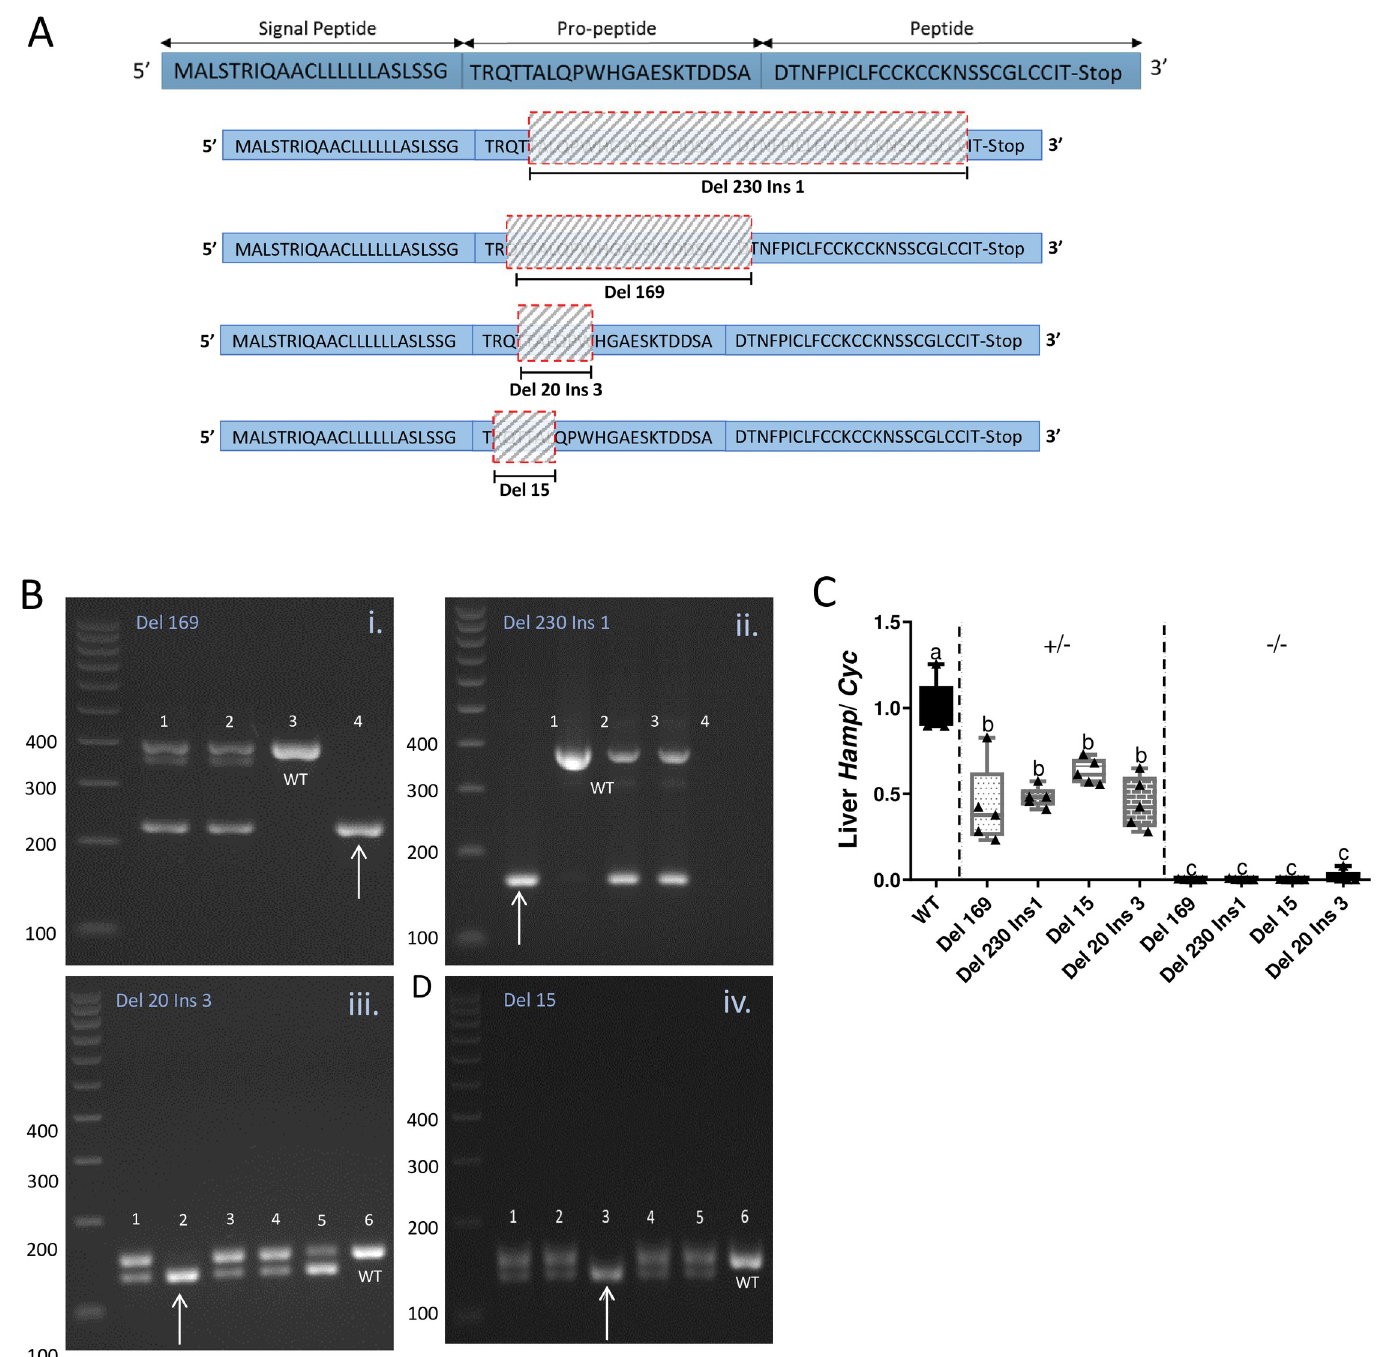
Fig 1. Hamp ablation strategy and confirmation. Four hepcidin KO rat lines were generated using a TALEN approach, targeting the second exon of the rat Hamp gene. The amino acid sequence of rat hepcidin is shown, along with the regions that were deleted in the different mutant rat lines ( A ). PCR genotyping confirmed the appropriate Hamp deletions in each KO line ( B ). Representative genomic PCR reactions were loaded on a 2% agarose gel and electrophoresed for 60 min at 120V. A single larger band is indicative of the WT allele; two bands indicate heterozygotes, and one smaller band indicates the homozygous null KOs (see arrows). Expected band sizes were 228 bp and 167 bp for the larger deletions (Del 169 and Del 230 Ins 1, respectively), and 136 bp and 138 bp for the smaller deletions (Del 20 Ins 3 and Del 15, respectively). Bands indicating WT rats were 397 bp for the two larger deletions and 153 bp for two smaller deletions. A 100 bp DNA ladder was used (leftmost lane) for reference. Furthermore, hepatic hepcidin mRNA levels were quantified in WT, heterozygous and homozygous null animals using quantitative RT-PCR ( C ). Data are presented as box plots for n = 5 rats per group and were analyzed by 2-way ANOVA followed by Tukey’s multiple comparisons post-hoc test. Means without a common letter differ significantly ( p < 0.05). Mutation × Genotype, p < 0.0001.